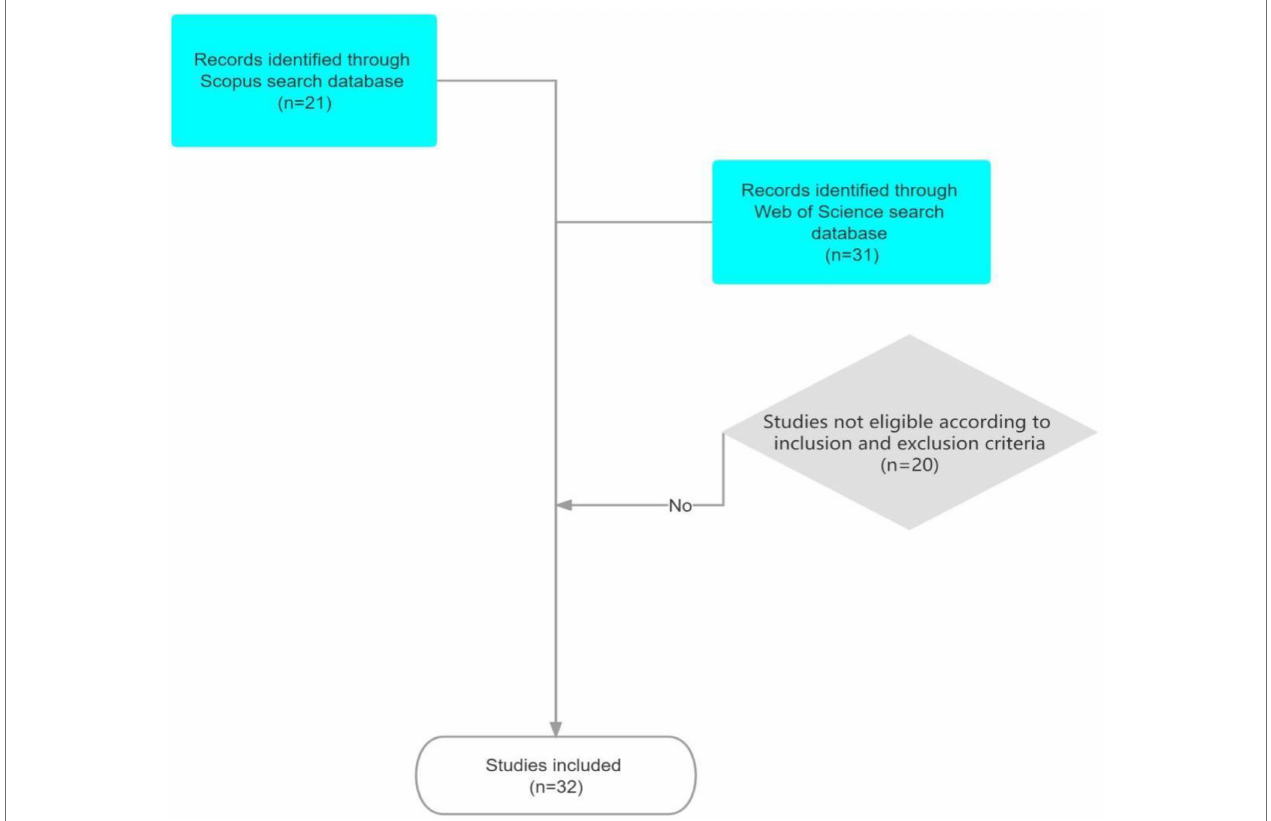
FIGURE 1 | Inclusion and exclusion criteria from Zairul (2021) for thematic review (TR). Reproduced with permission.